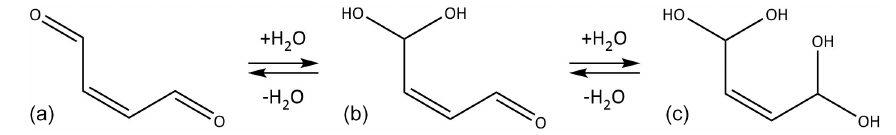
Figure 2. Butenedial (a) in equilibrium with its singly (b) and doubly (c) hydrated forms. The cis isomers of butenedial and its hydrates are shown here but no assumptions are made about the geometric isomer studied in this